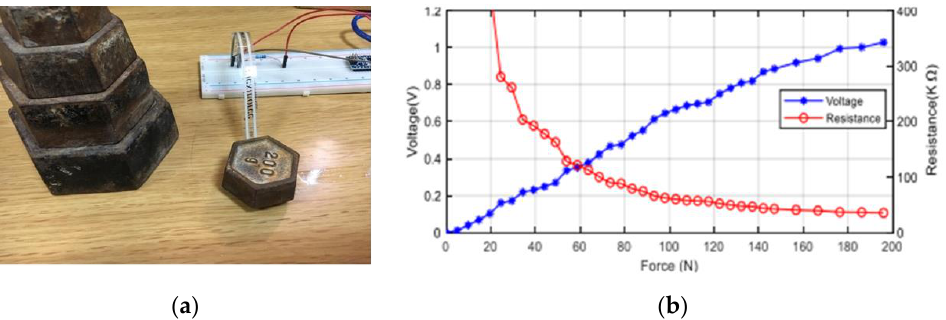
Figure 3. The calibration process ( a ) FlexiForce with weights for calibration ( b ) The relationship between the force values with the output voltage values and FlexiForce resistance values.